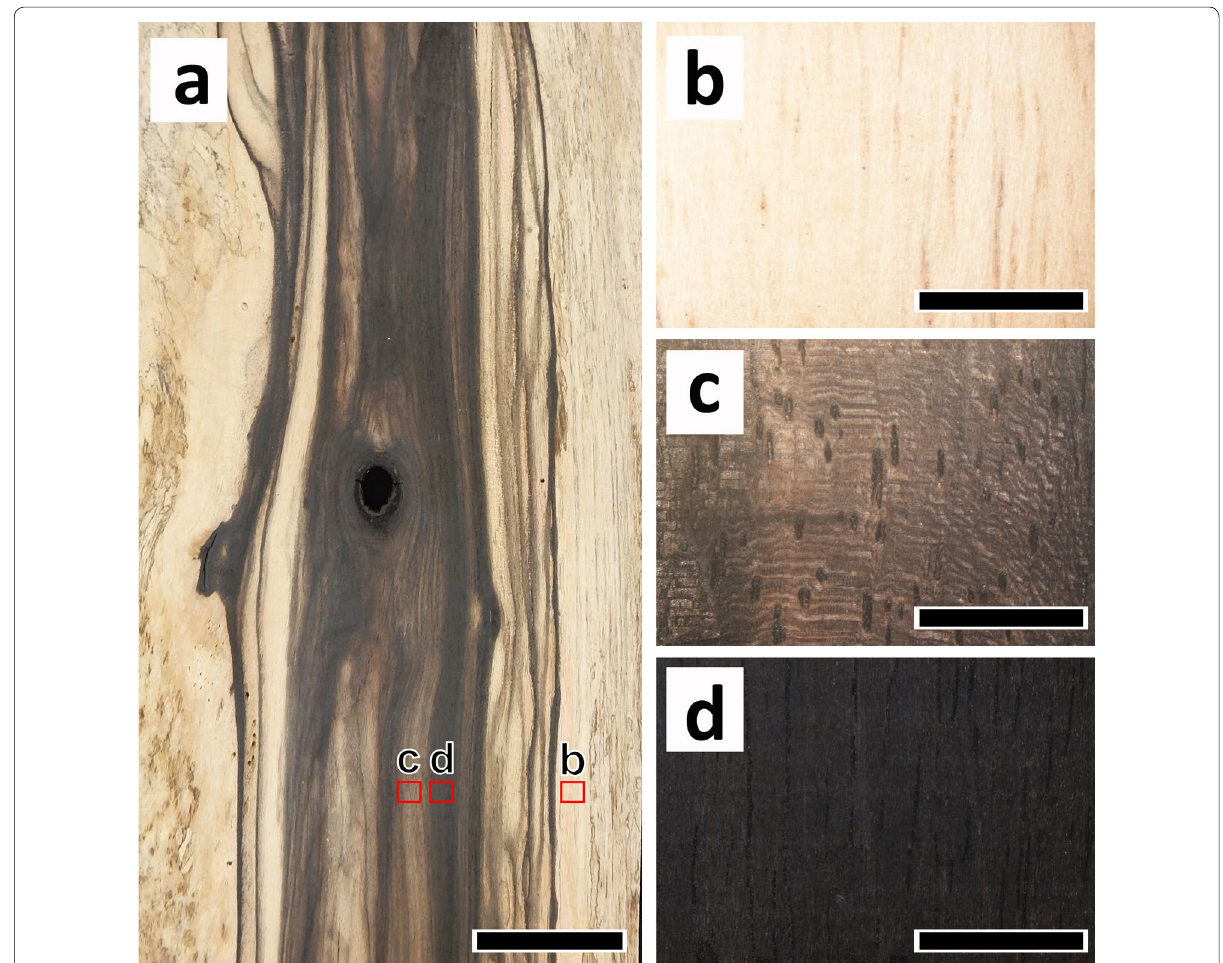
Fig. 1 A photograph ( a ) and micrographs obtained by stereo microscopy ( b – d ) of typical wood samples used in this study. Wood of D. kaki that contained some black regions was examined ( a ). Wood samples were divided into three parts by color, namely, whitish ( b ), gray ( c ) and black ( d ). Scale bars 10 cm in a ; 5 mm in b – =